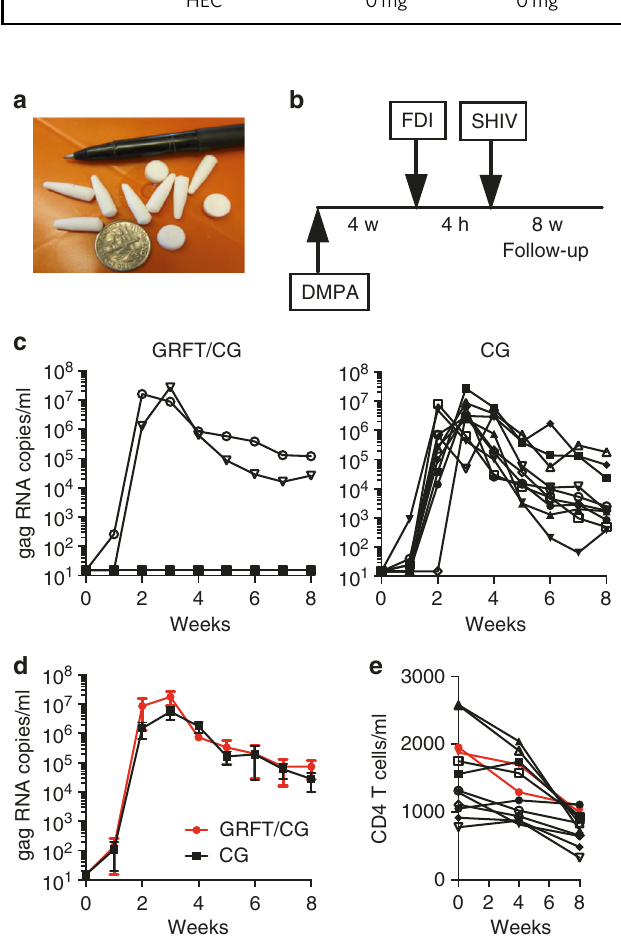
Fig. 1 GRFT/CG FDIs protect macaques from SHIV infection. a Macaque sized FDIs. b Schematic of the macaque challenge study. c Plasma viral RNA copies/ml of SHIV over time following challenge in macaques administered FDIs. DMPA-treated macaques were challenged with 300 TCID 50 SHIV SF162P3 4 h after vaginal administration of either GRFT/CG FDIs (left, n = 10, 2 of 10 infected) or control CG FDIs containing all the same components except GRFT (right, n = 10, 10 of 10 infected). The percent of infected animals in each group was compared at the conclusion of the study by Fisher ’ s Exact test. d The means with standard error of the mean (SEM) are shown as symbols with error bars for macaques that became infected during the study in the presence of the GRFT/CG (red symbols, n = 2) or CG (black symbols, n = 10) FDIs. e The number of CD4 T cells per milliliter (ml) of blood is shown over time for all macaques that became infected. Macaques exposed to GRFT/CG FDIs are in red and to CG FDIs in black